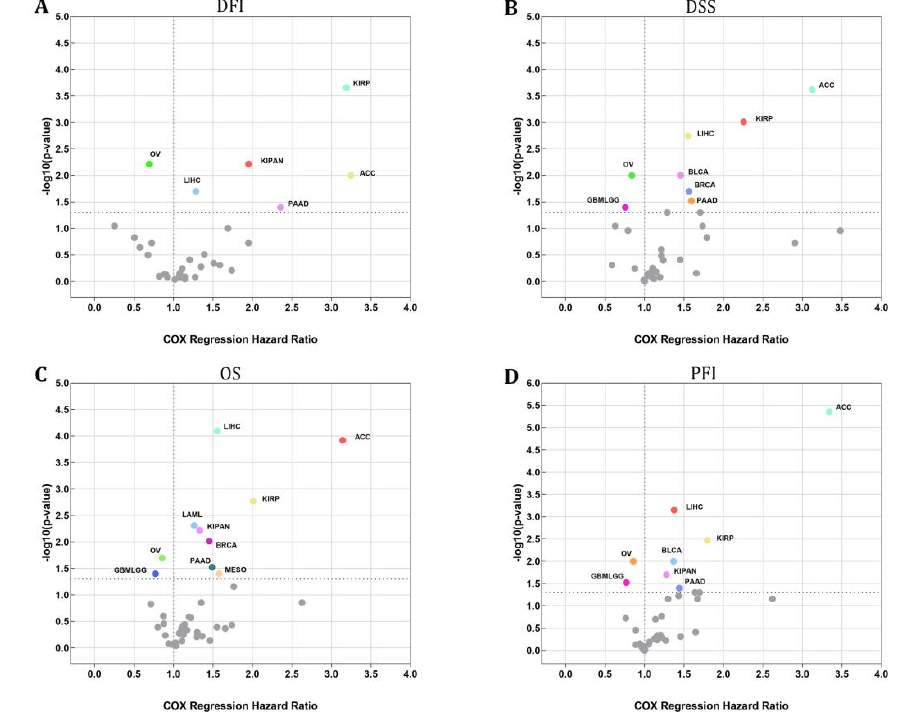
Figure 2. The STX6 level can sufficiently predict the prognosis of patients with cancer. Cox regression analysis showed that patients with high levels of STX6 showed a poor prognosis in DFI, DSS, OS, or PFI, especially patients with LIHC, ACC, PAAD, and KIRP, whereas OV and GBMLGG patients showed the opposite ( A – D ).